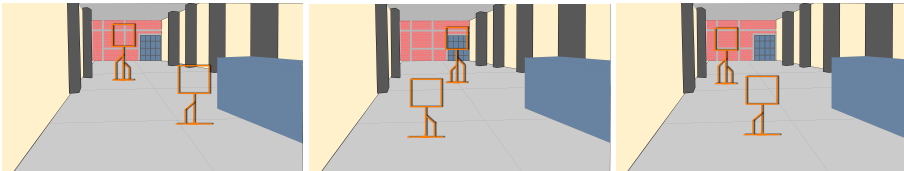
Figure 12. Schematic view illustrating different combinations of gate positions for our